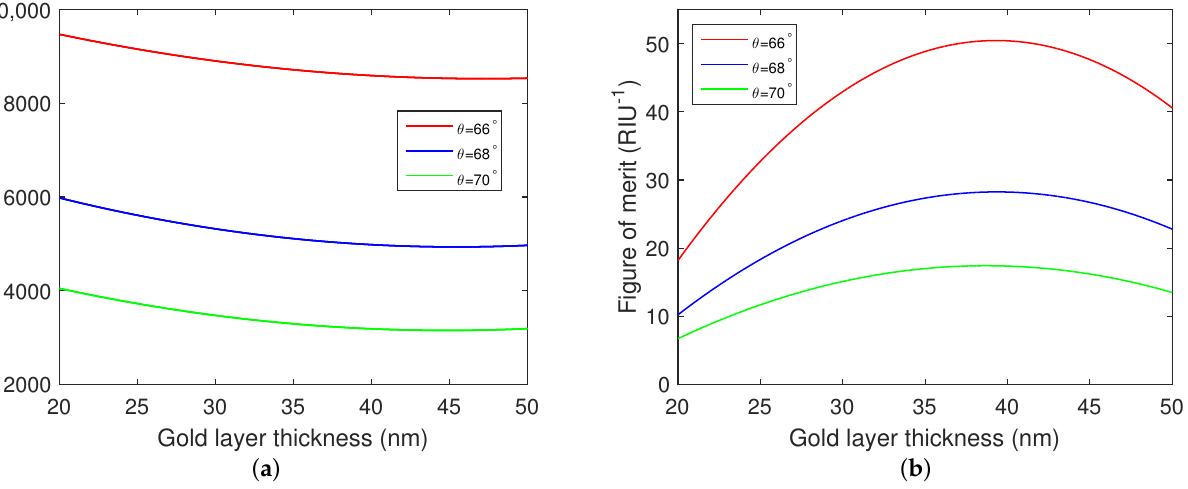
Figure 5. Theoretical RI sensitivity ( a ) and figure of merit ( b ) as a function of the gold layer thickness when water was considered as an analyte. Silicon dioxide thickness t SiO thickness t Cr = 2 nm. Angles of incidence θ = 66 ◦ , 68 ◦ , and 70 ◦